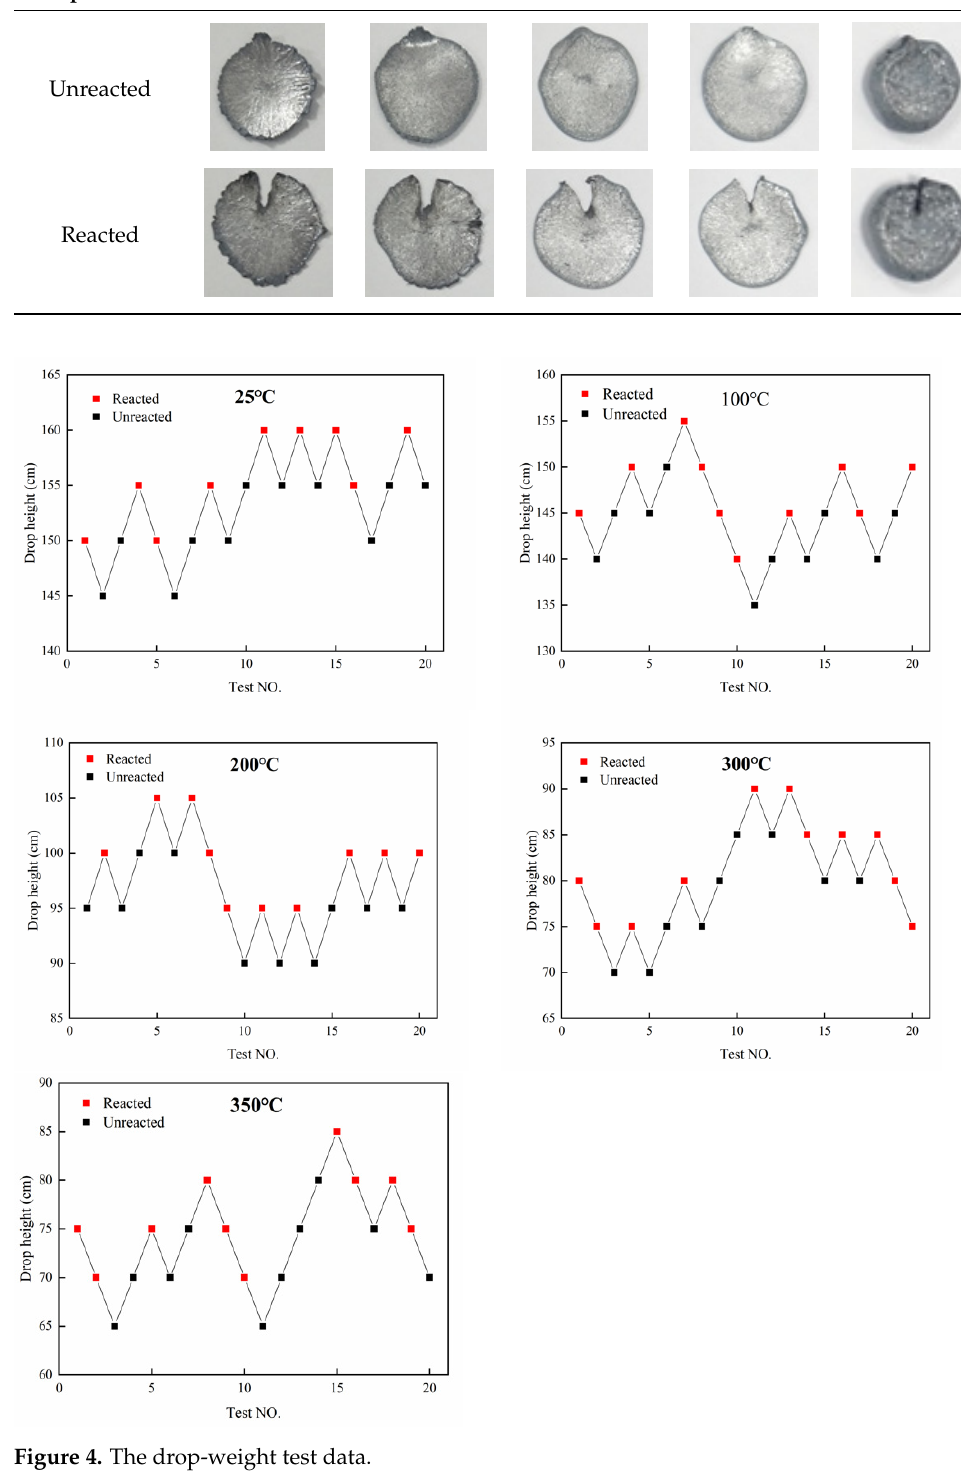
Figure 4. The drop-weight test data. Table 2. The calculated results of drop-weight tests.